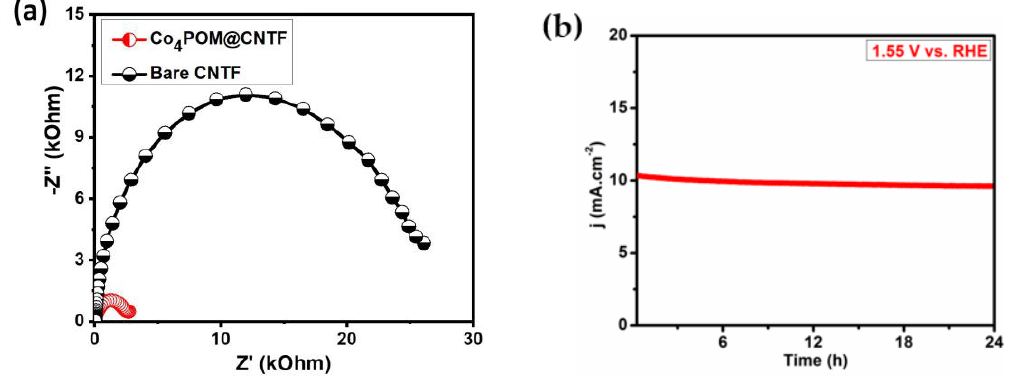
Figure 5. ( a ) Nyquist plot for the bare CNTF and Co 4 POM@CNTF; ( b ) stability test for Co 4 POM@CNTF in 0.1 M KOH for 24 h at 1.55 V versus